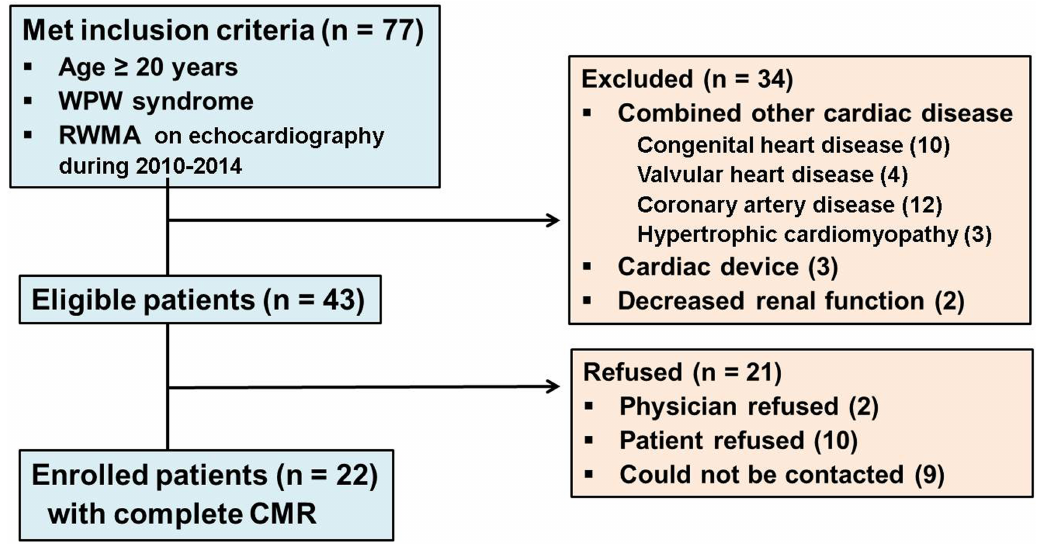
Fig 1. Flow chart for the study population. CMR = cardiac magnetic resonance imaging; RWMA = regional wall motion abnormality.